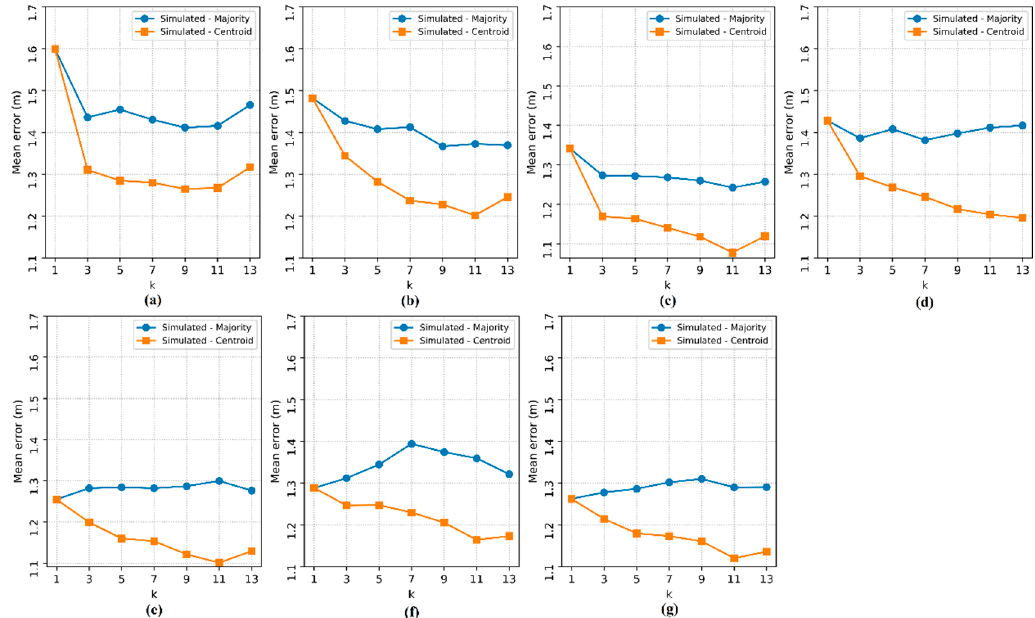
Figure 12. Localization mean error in the simulated environment with an area of 14 m × 14 m. The subfigures show the tests for each number of access points: ( a ) 2 APs, ( b ) 3 APs, ( c ) 4 APs, ( d ) 5 APs, ( e ) 6 APs, ( f ) 7 APs and ( g ) 8 APs.